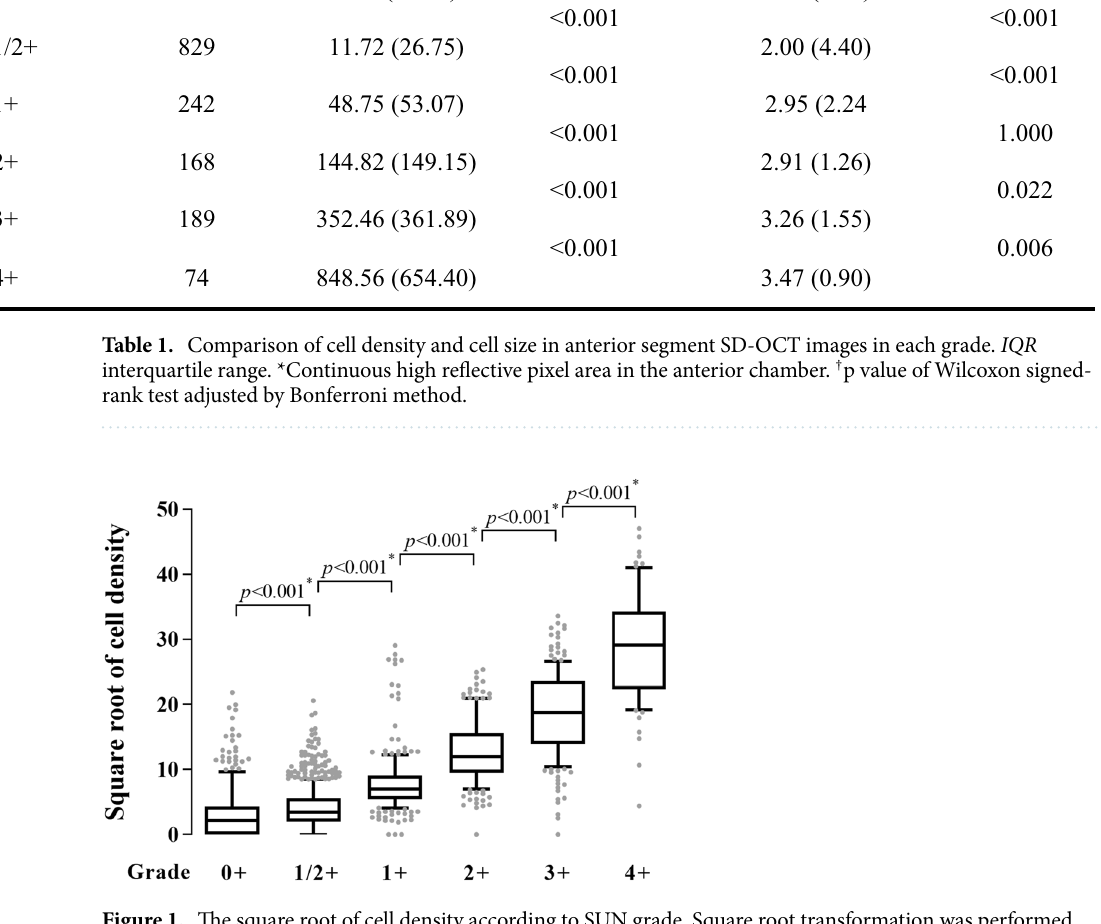
Figure 1. The square root of cell density according to SUN grade. Square root transformation was performed because the intervals between SUN grades are not equal, and the intervals increase with increasing grade. The cell density also increased significantly with increasing SUN grade. The boxes indicate the median and interquartile range, and the whiskers indicate 10–90